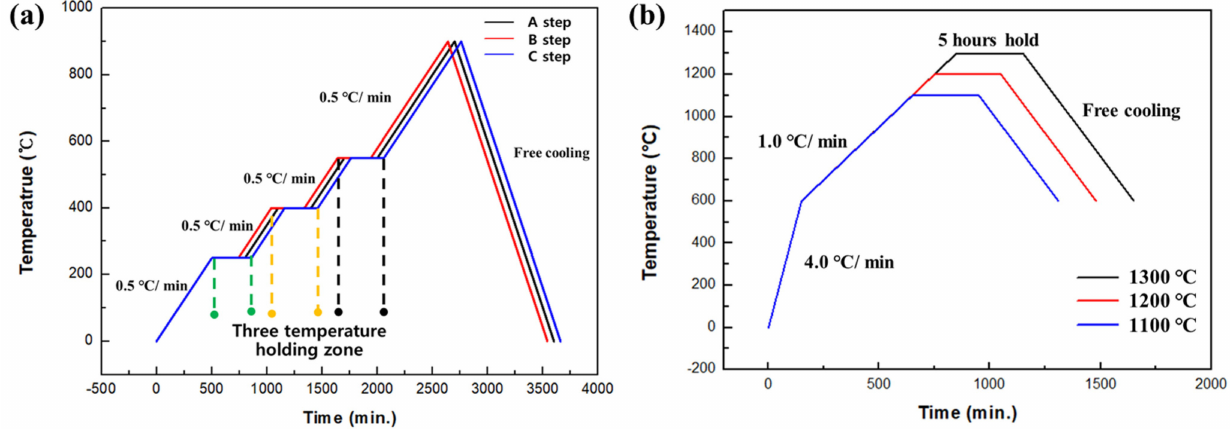
Figure 3. Debinding ( a ) and sintering ( b ) profiles. (A step: 4 h, B step: 5 h, C step: 6 h, “step” refers to the three temperature holding zone times).